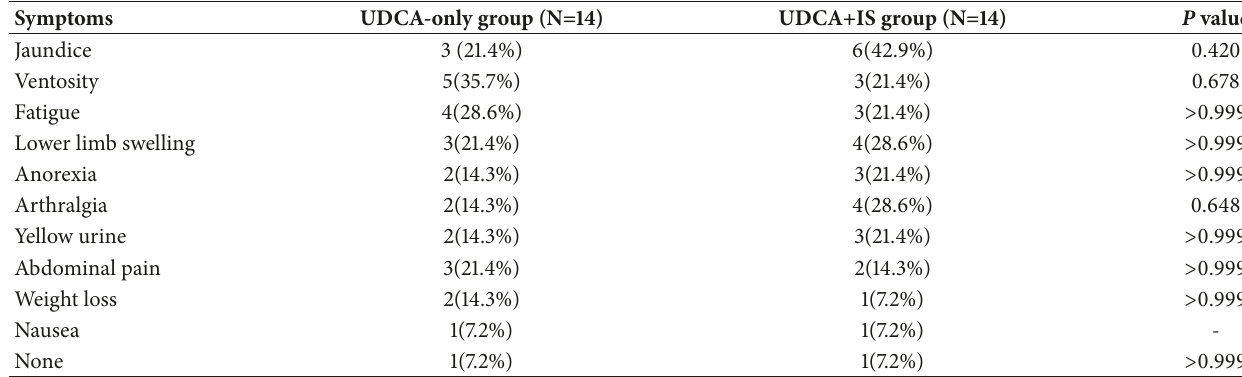
Figure 1: Study flowchart for patient inclusion. Table 2: Comparison of symptoms between the two groups at